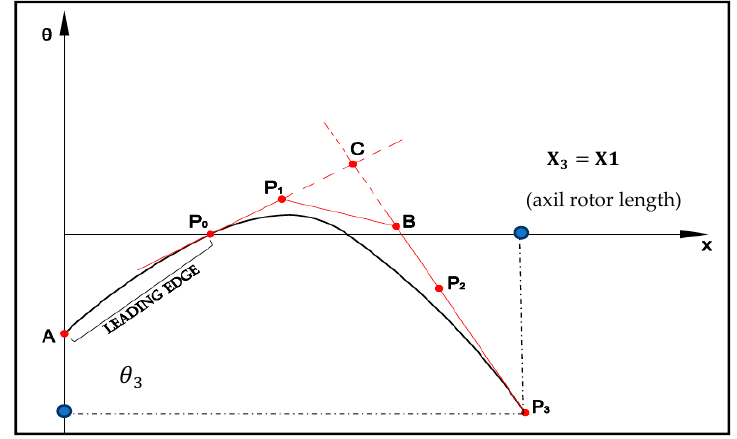
Figure 2. The camber line blade view [42].